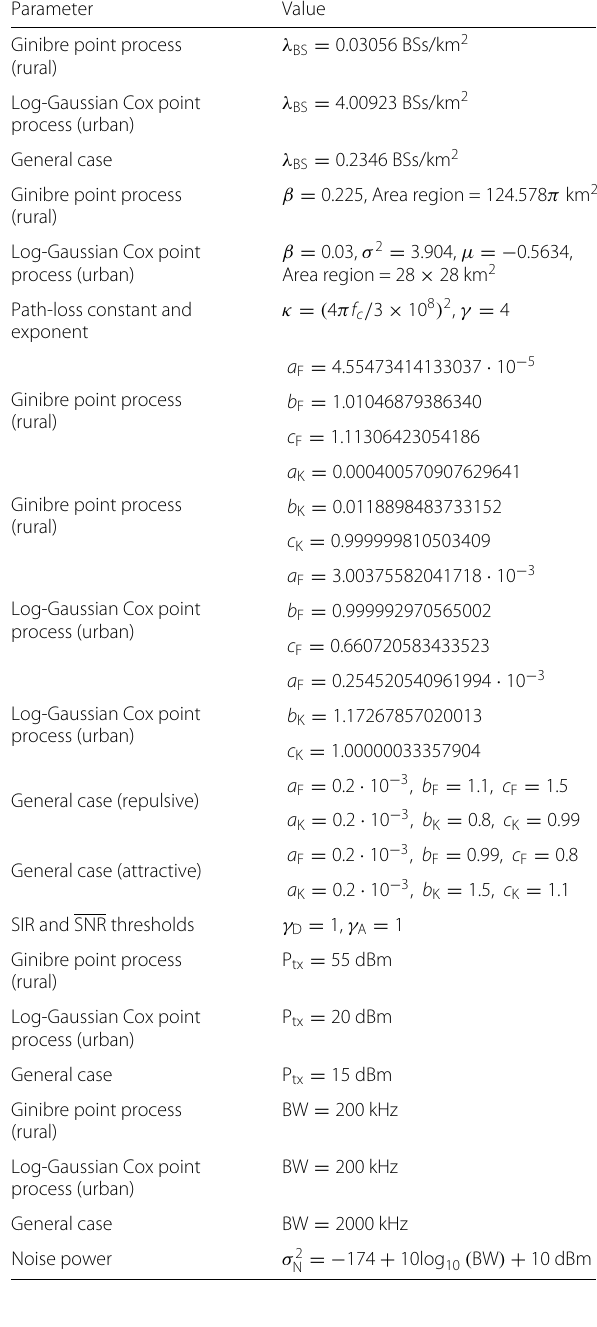
Table 1 Simulation